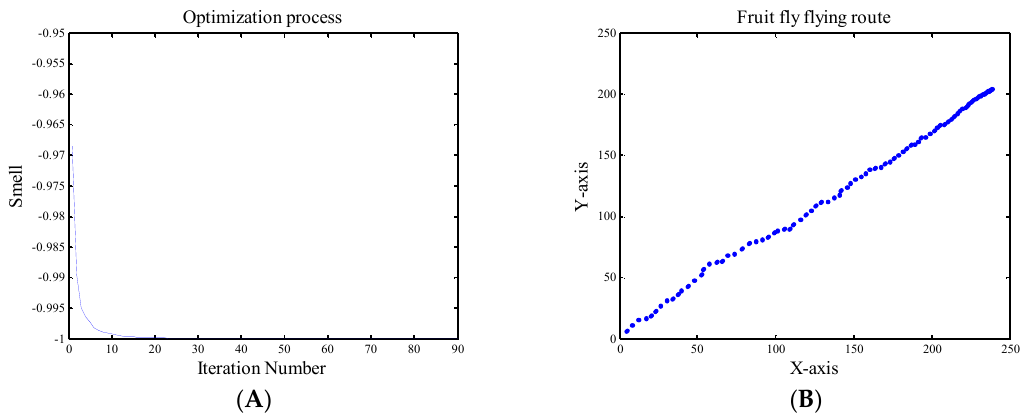
Figure 9. ( A ) Optimization process of FOA2; and ( B ) fruit fly flying route of FOA2.